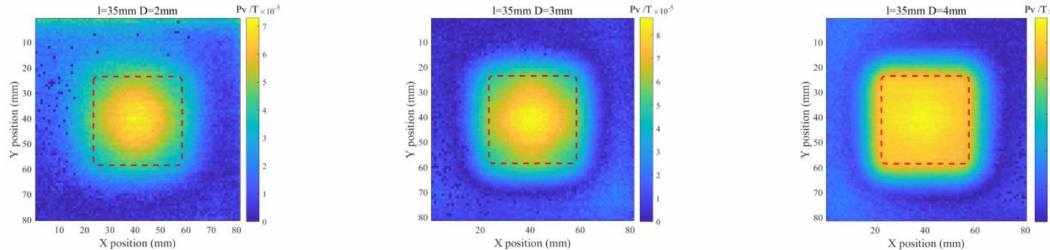
Figure 9. Imaging results for ILC Scenario #2.